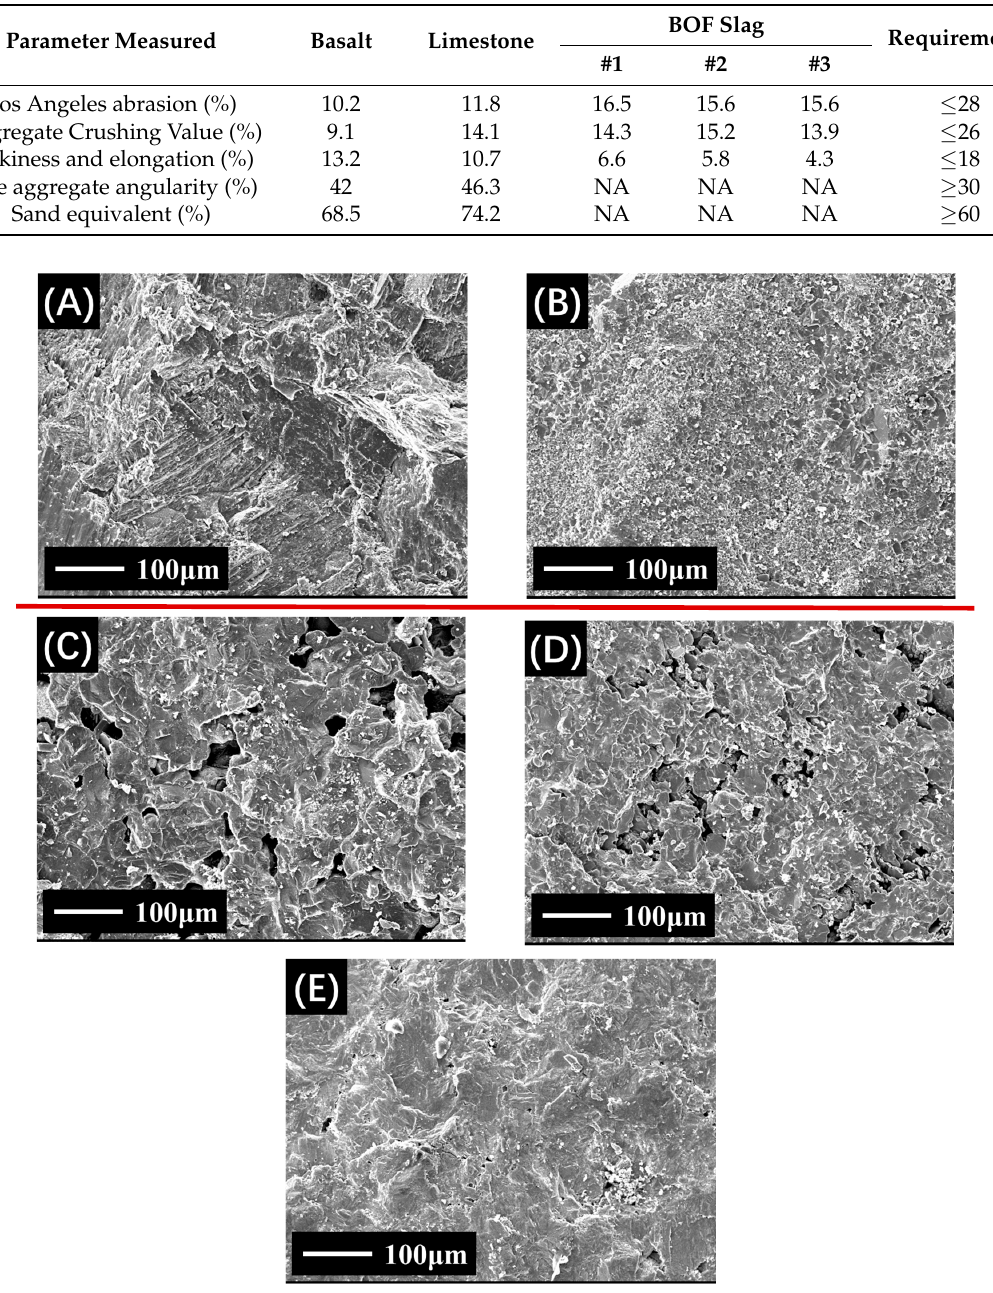
Figure 1. SEM images of investigated aggregates. A : Basalt; B : Limestone; C : #1 BOF slag, D : #2 BOF slag, E : #3 BOF slag, E : #3 BOF slag).